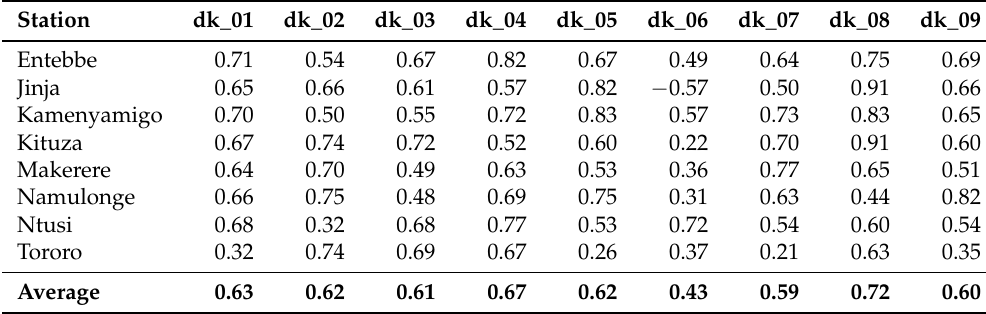
Table 3. Dekadal Pearson correlation coefficient over MAM.